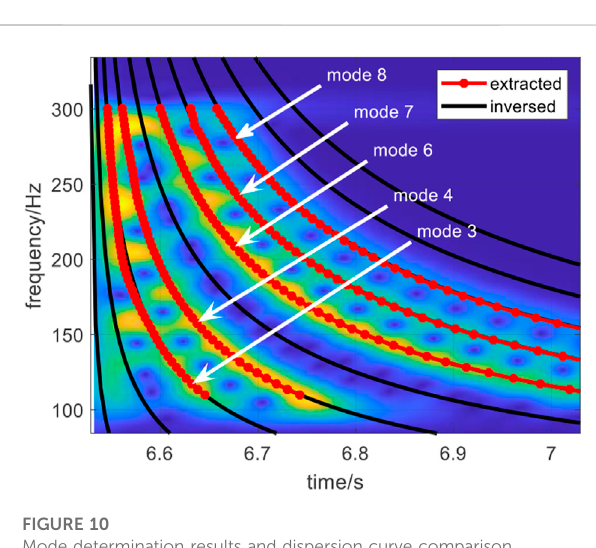
FIGURE 11 Sound speed pro fi le of data